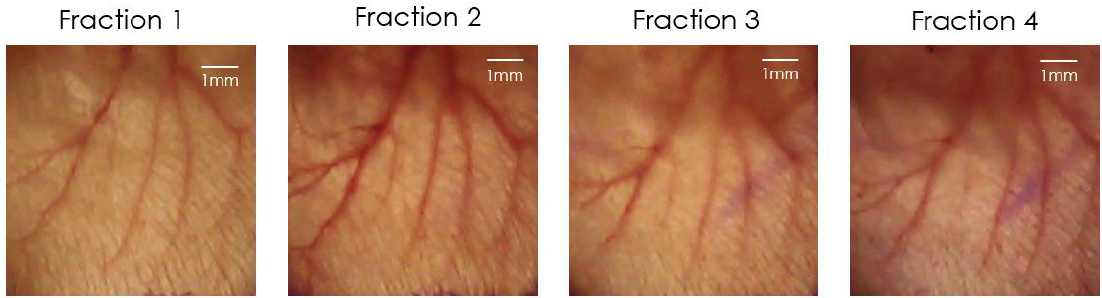
Figure 12. Illustration of the irradiation field for every fraction during the 4-fraction course.